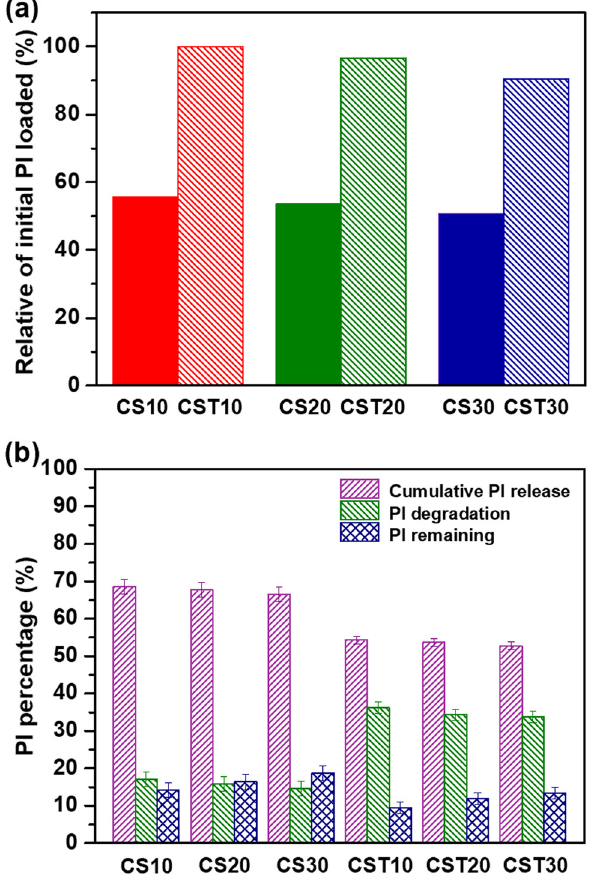
Figure 10: ( a ) Relative of the initial PI loaded of all nano fi ber mats and ( b ) cumulative PI release, PI degradation and PI remaining of all nano fi ber